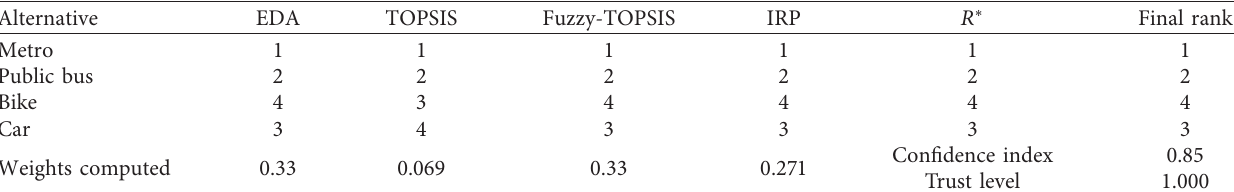
Table 13: Ensemble ranking technique